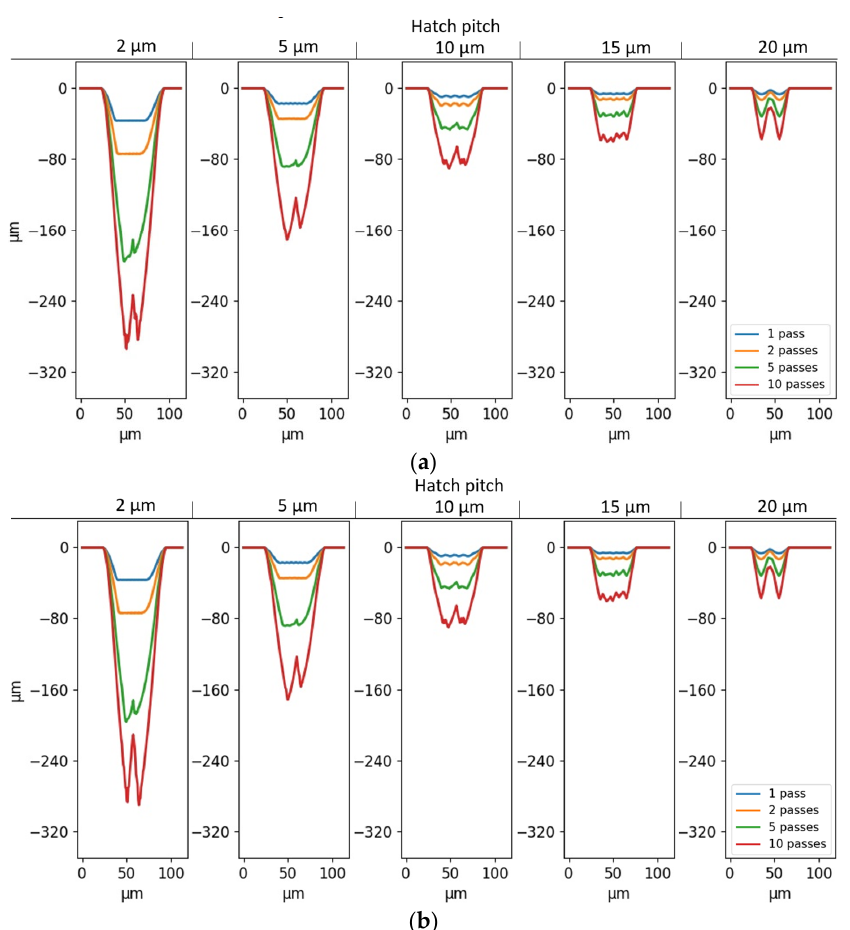
Figure 9. Simulated cross ‐ sections of ( a ) unidirectional and ( b ) bidirectional grooves without geometry ‐ dependent material parameters, as a function of hatch pitch and the number of passes.